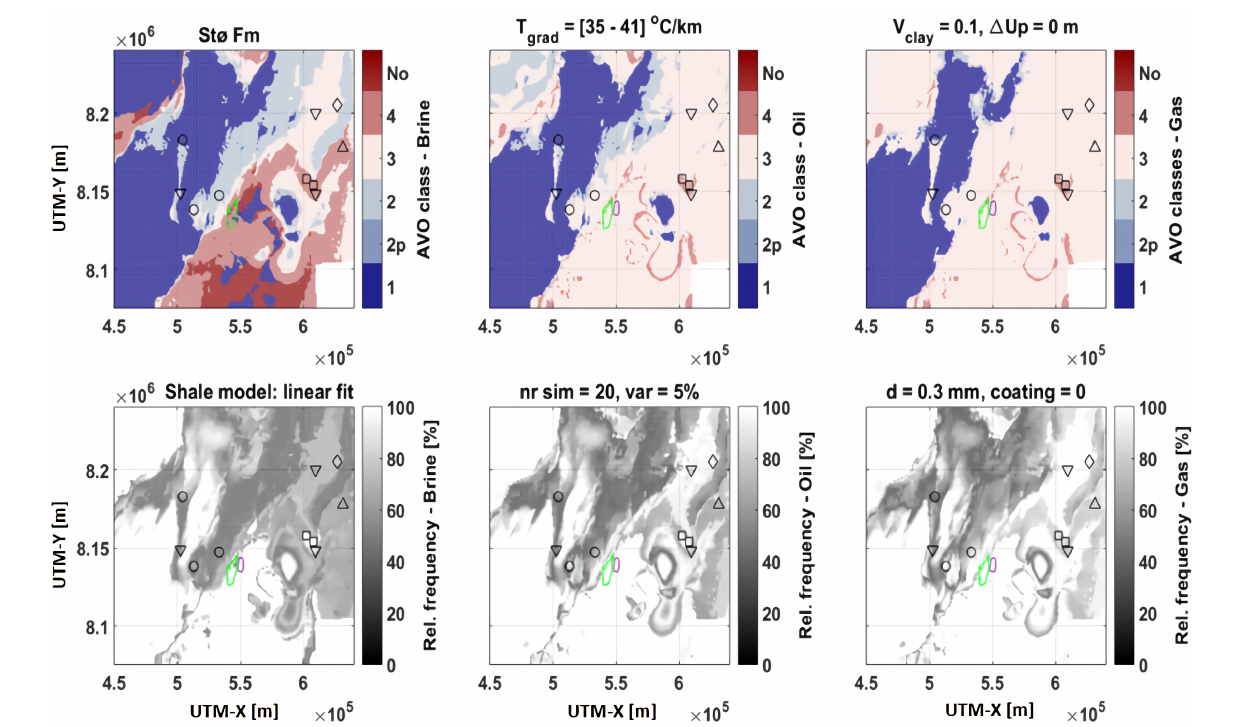
FIGURE 12 | Uncertainty assessment of AVO feasibility maps testing a range of constant temperature gradients. The white areas in the three lower subplots indicate where AVO classes do not change (i.e., low uncertainty). In contrast, the gray areas indicate where AVO classes will change within this temperature range (i.e., higher